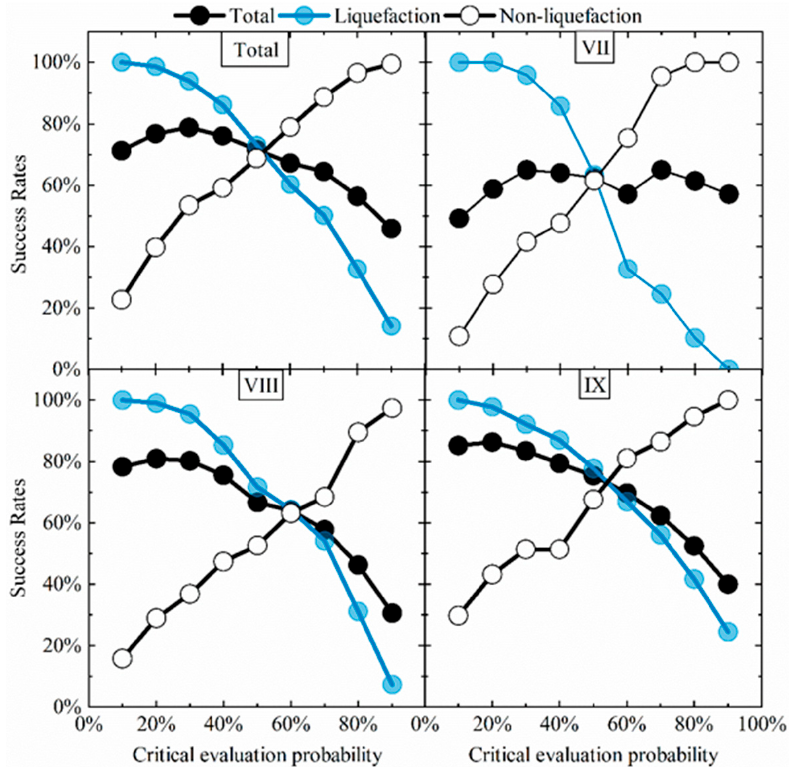
Figure 2. Success rates of different preset liquefaction probabilities for fitted samples. The data range in the figure is marked at the lower left corner, i.e., all the sites (TOTAL), zone VII, zone VIII, and zone IX.